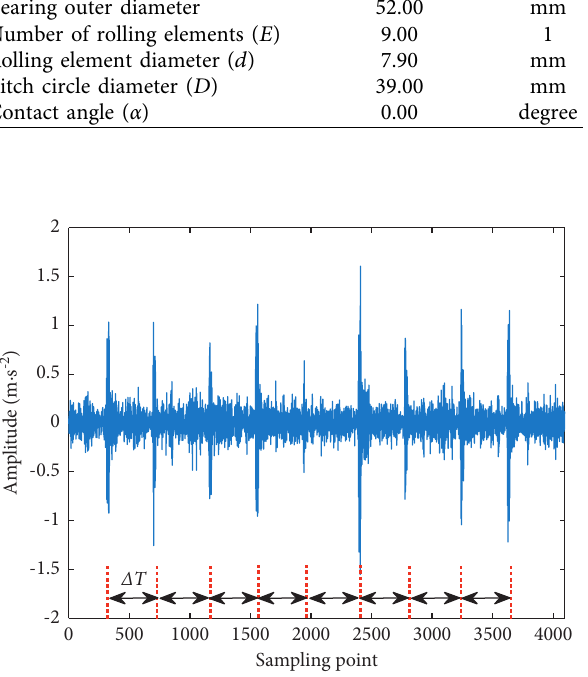
Figure 4: The time-domain trend of the employed data collected from SKF 6205-2RS deep groove ball bearing with inner ring